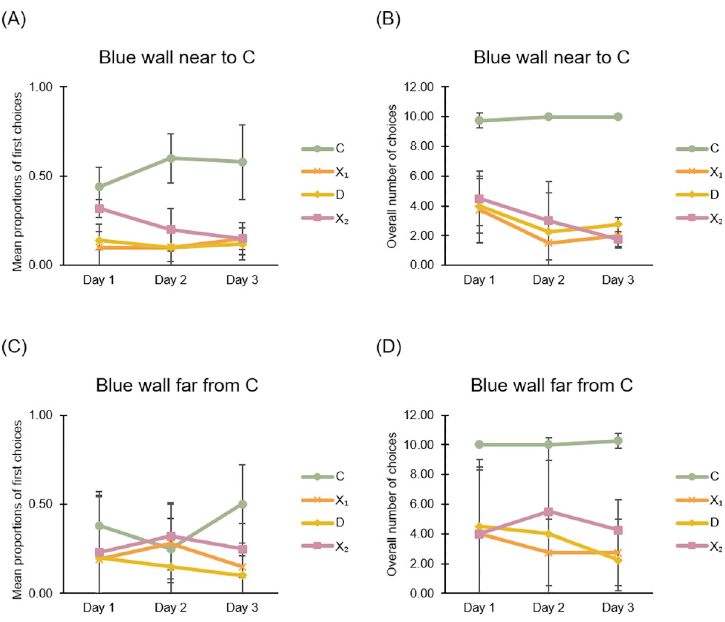
Fig 9. Learning in Experiment 4: Reference memory task in square apparatus with blue wall. (A) and (B): Graphs show mean (SD) choices at four corridors during the three daily sessions of training (of locating the exit through reference memory) in the square apparatus with the blue wall near to the correct corner C, considering in (A) the proportions of first choices and in (B) the overall number of choices. (C) and (D): Graphs show mean (SD) choices during the three daily sessions of training in the square apparatus with the blue wall far from the correct corner C, considering the proportions of first choices (C) and the overall number of choices (D). subjects factors and Distance of C from the blue wall (C adjacent to the blue wall vs . C distant from the blue wall) as between-subjects factor.